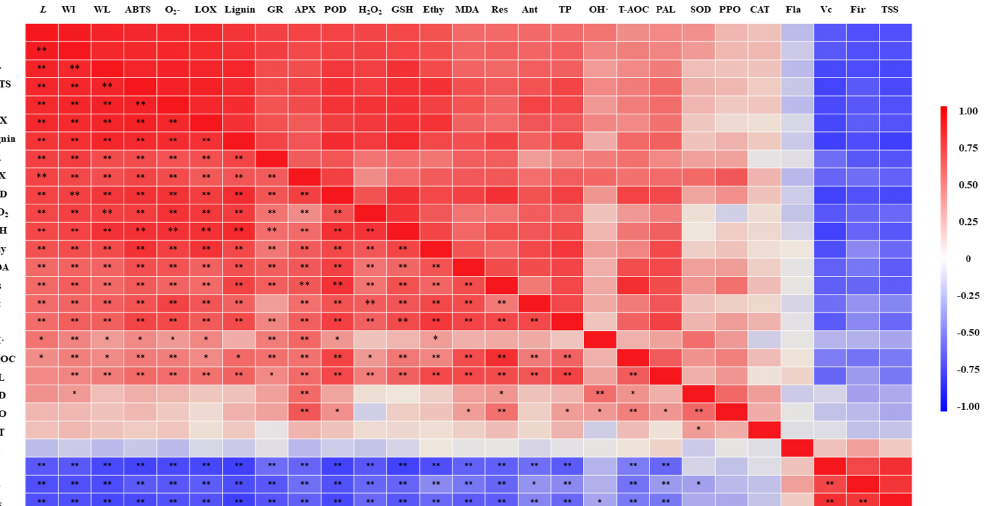
Figure 9. Pearson correlation matrix of indexes. * indicates significance at the p < 0.05 probability level. ** indicates significance at the p < 0.01 probability level. WL, Ethy, Res, Ant, TP, Fla and Fir represent weight loss, ethylene, respiration, anthocyanin, total phenols, flavonoids and firmness, respectively.